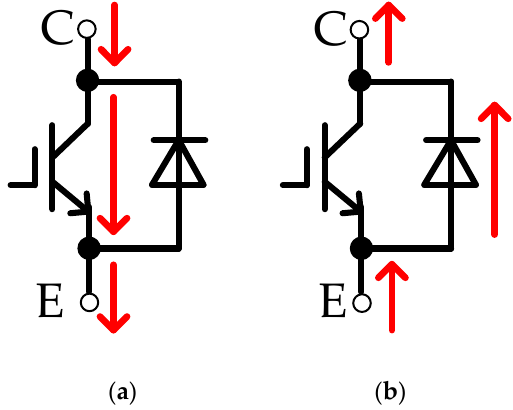
Figure 5. IGBT and FWD current flow differences. ( a ) IGBT current flow; ( b ) FWD current flow.